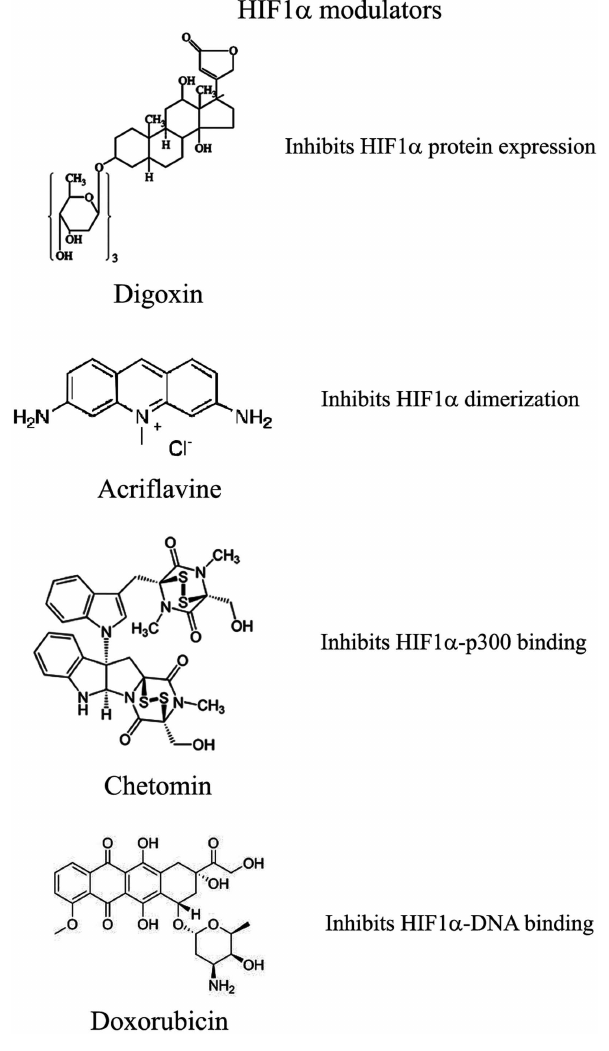
FIGURE 3 | Selection of compounds that can be used to modulate HIF1 α